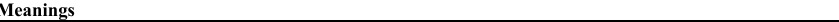
Exploratory Factor Analysis Criteria Value Meanings KMO